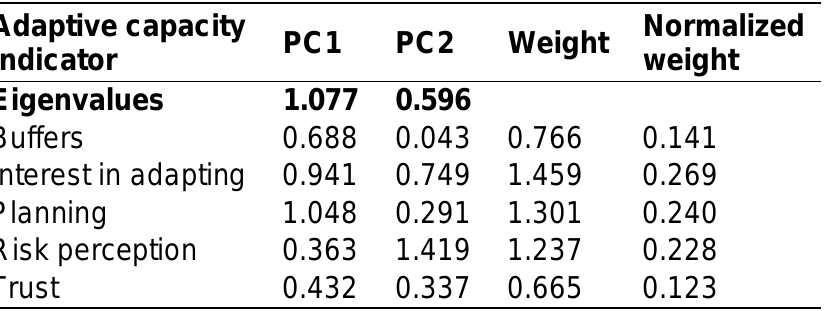
Table S4. Absolute factor loadings, weights, and normalized weights of each adaptive capacity indicator on PCA